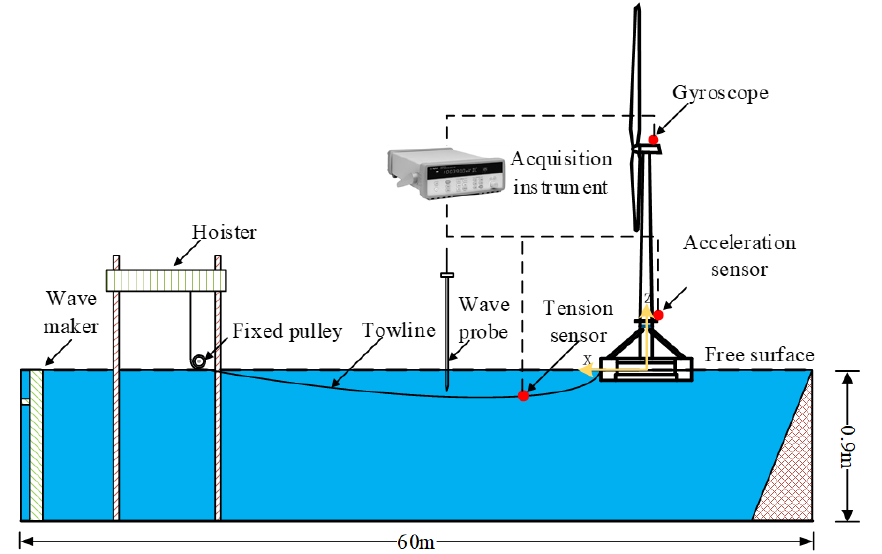
Figure 6. Schematic diagram of towing experiments.